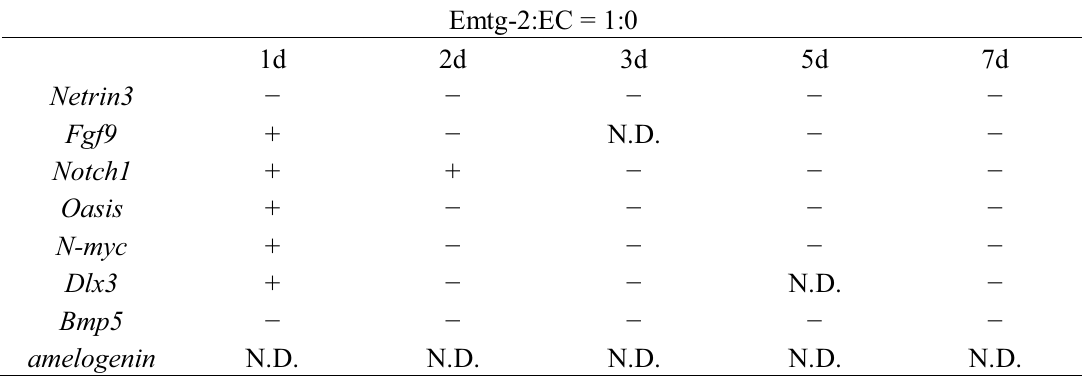
Figure 11. Expressions of Oasis and Dlx3 at a high magnification in germs cultured for one day. (a-1, 2) In-situ hybridization in reconstructed germs with EC and MT (positive control). (b-1, 2) In-situ hybridization in reconstructed germs with emtg-2 cells and EC (1:0.5) and MT. (c-1, 2) In-situ hybridization in reconstructed germs with emtg-2 cells and MT. (a-1, b-1, c-1) Expression of Oasis in reconstructed germs. (a-2, b-2, c-2) Expression of Dlx3 in reconstructed germs. e: epithelium, m: dental mesenchyme. Scale bar